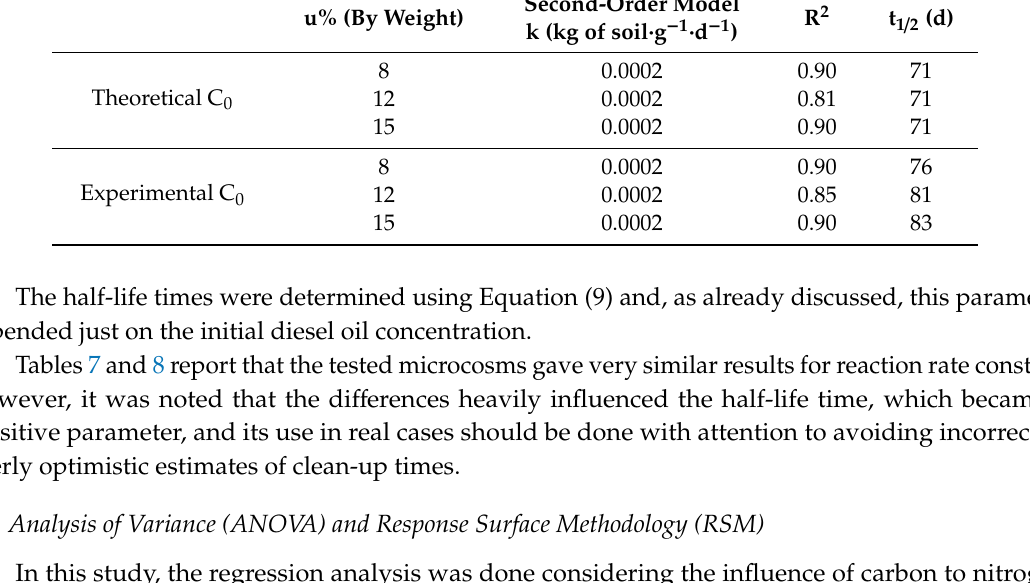
Table 8. Second-order reaction rate constant and half-life time for microcosms with C / N = 180. Second-Order Model u% (By Weight)